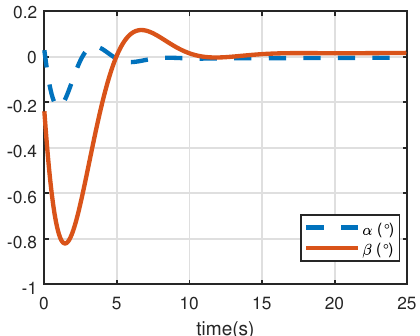
Figure 6. The evolution of rotation angles α and β